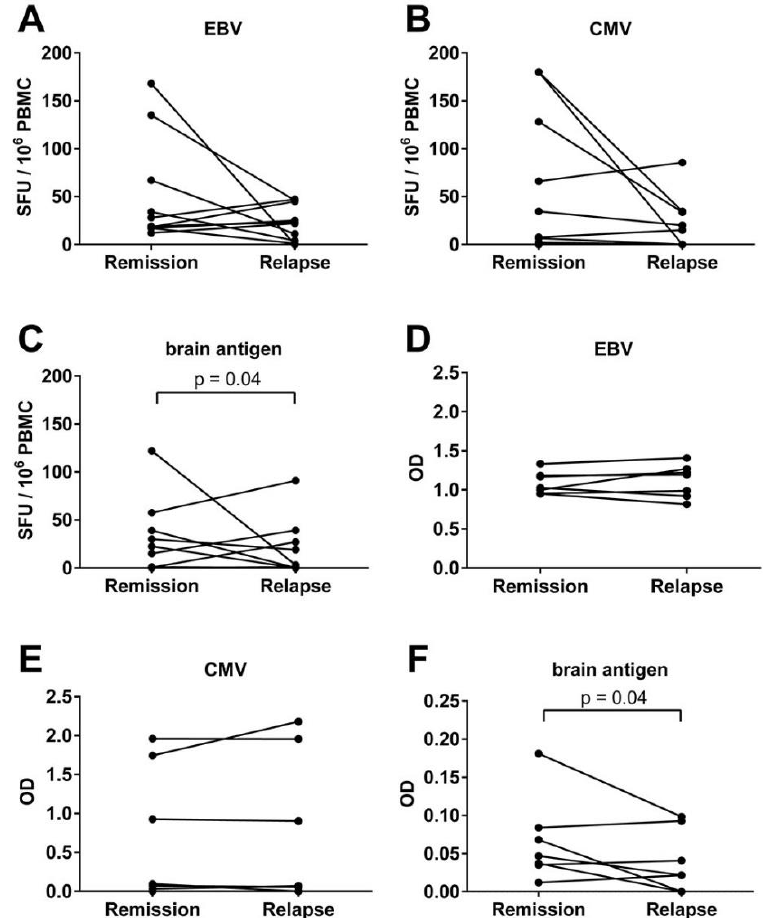
Figure 5. Similar magnitude of the virus-specific B cell response in relapse and remission. The frequencies of EBV- ( A ) CMV- ( B ) and brain antigen-specific ( C ) B cells and the plasma antibody levels for EBV ( D ), CMV ( E ) and brain antigen ( F ) were detected in n = 10 MS patients experiencing a relapse and in the same MS patients in remission. The results for the individual donors are displayed.